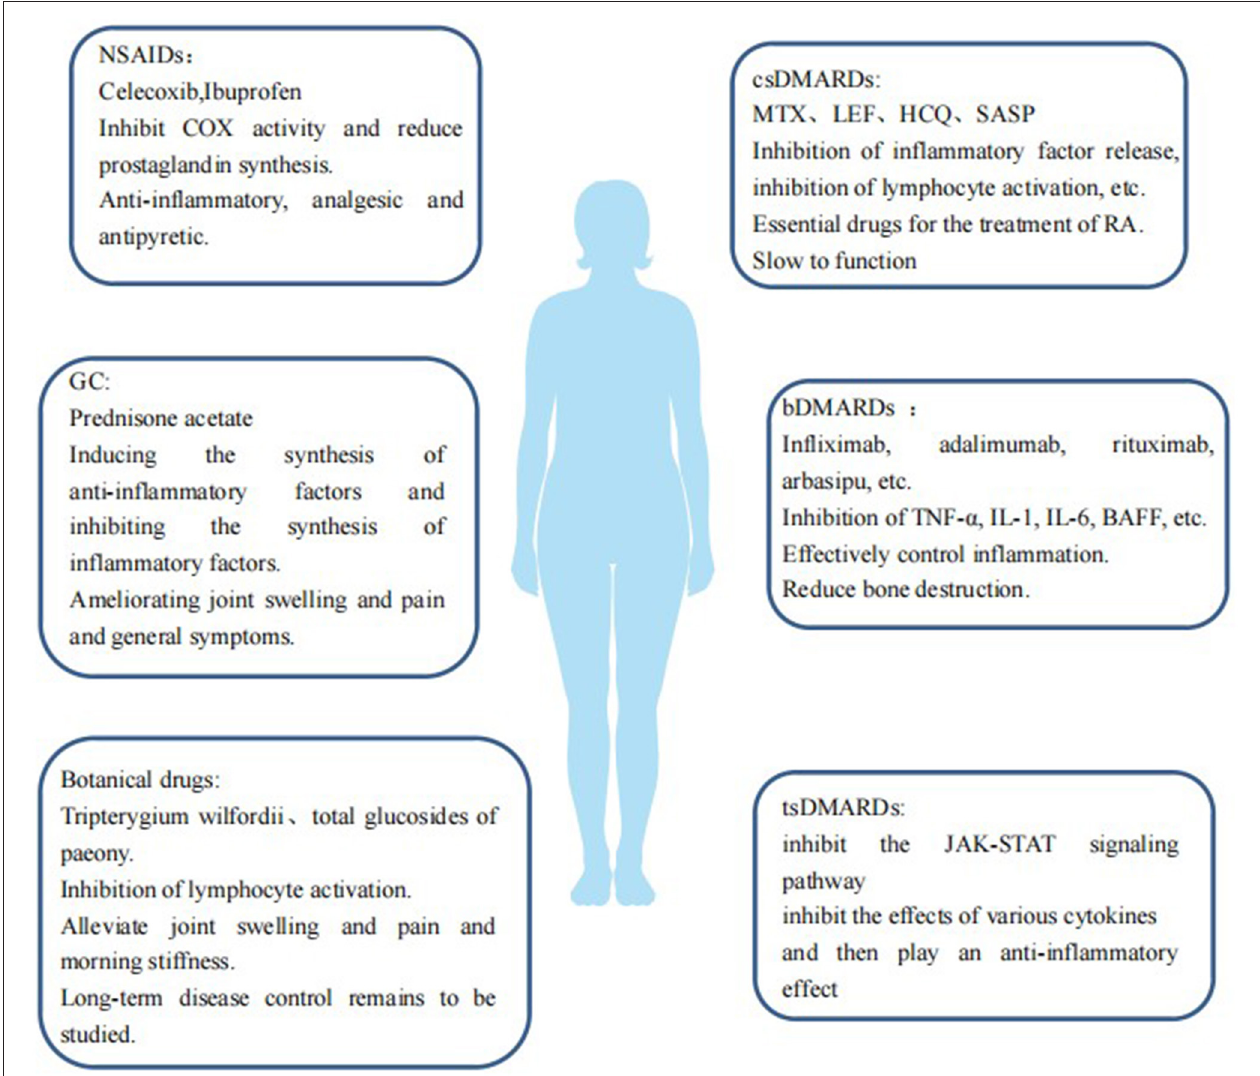
FIGURE 1 | Therapeutic drugs for RA are a double-edged sword in case of RA-induced CVDs. Some drugs may reduce the incidence of CVDs in patients with RA by inhibiting inflammation and improving endothelial function and insulin resistance, and some drugs may impair the mechanism of vascular repair, have harmful effects on the cardiovascular system, and increase the risk of developing CVDs. We will explain the effects of these drugs on the cardiovascular risk of patients with RA.